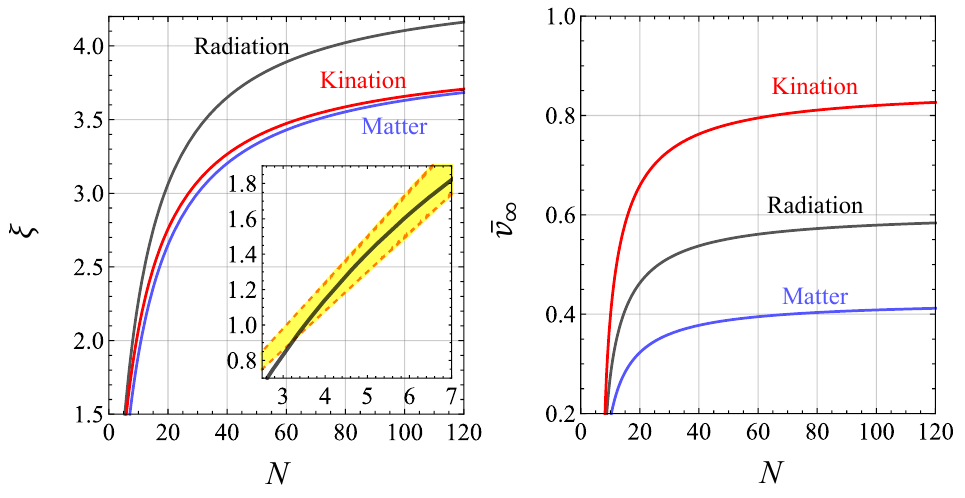
Figure 1 . The number of global string per Hubble volume ξ and the average long string velocity ¯ v as functions of N ≡ ln L , as predicted by the VOS model, for different background cosmologies. ∞ δ The subfigure in the left panel is the zoom-in of ξ evolution in the low N range during radiation domination, where the yellow band shows the 1- σ uncertainty region based on the finding by simulation (as shown in eq. (2.9) with β ∼ 0 . 20